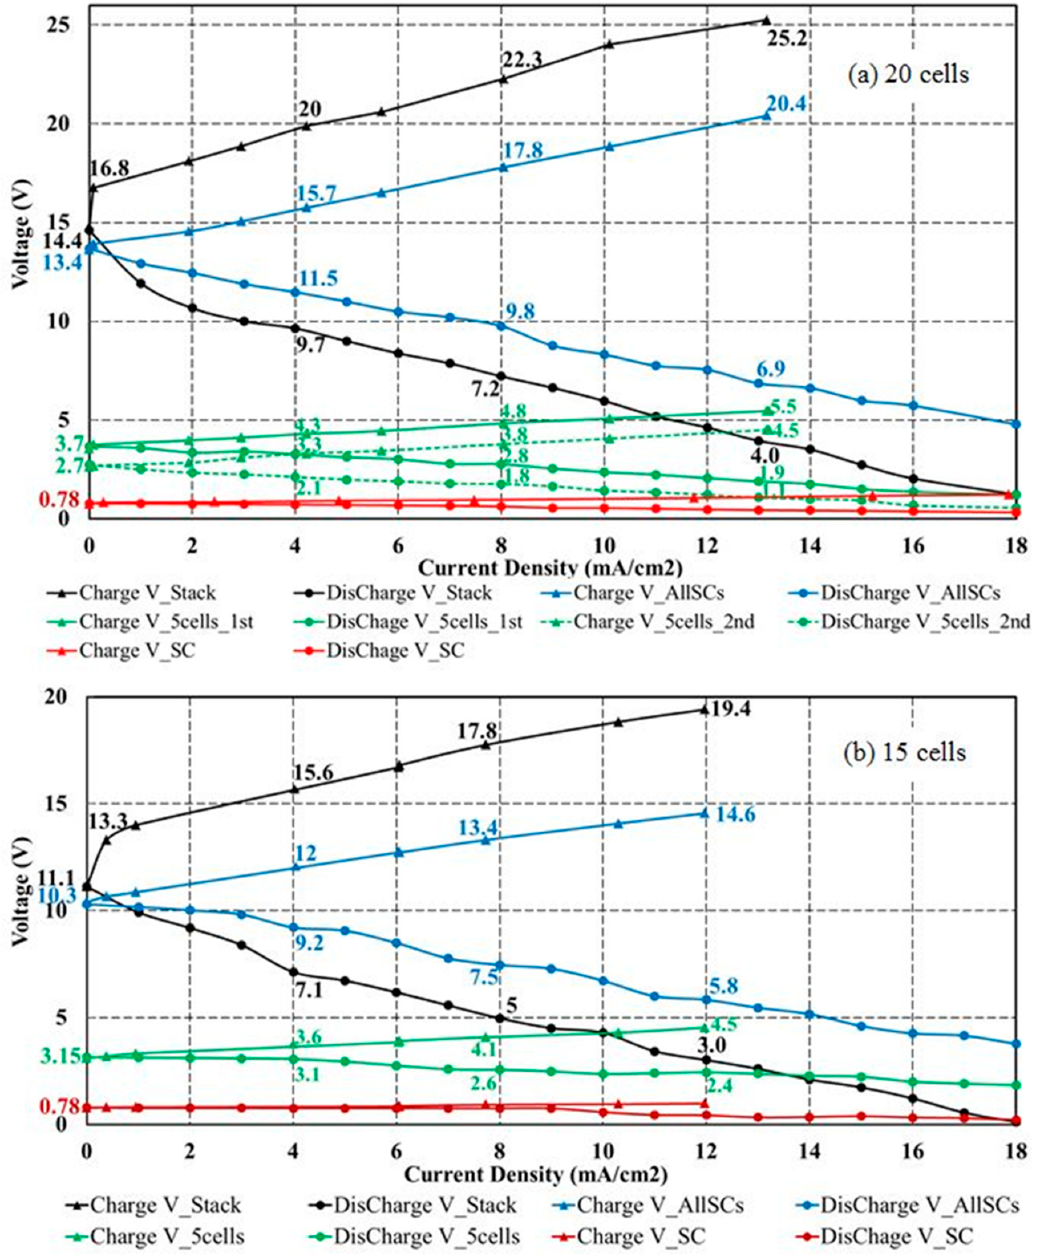
Figure 8. Current density measurements during charge and discharge with 1 M acid and base at 25 °C and 0.1 MPa at steady state. Current-voltage curves of positive slope represent charging, of negative slope discharging. Results for a 20-cell stack are shown in ( a ) and for a 15-cell stack in ( b ). Displayed are the measured voltages, VSC (across BP (bipolar membranes) of the first single cell, red), V5cell_2nd (across the second 5-cell unit, green dotted), V5cell_1st (across the first 5-cell unit, green solid), VAllSCs (across all cell units measured between Pt electrodes, blue) and VStack (stack voltage between electrodes, black).